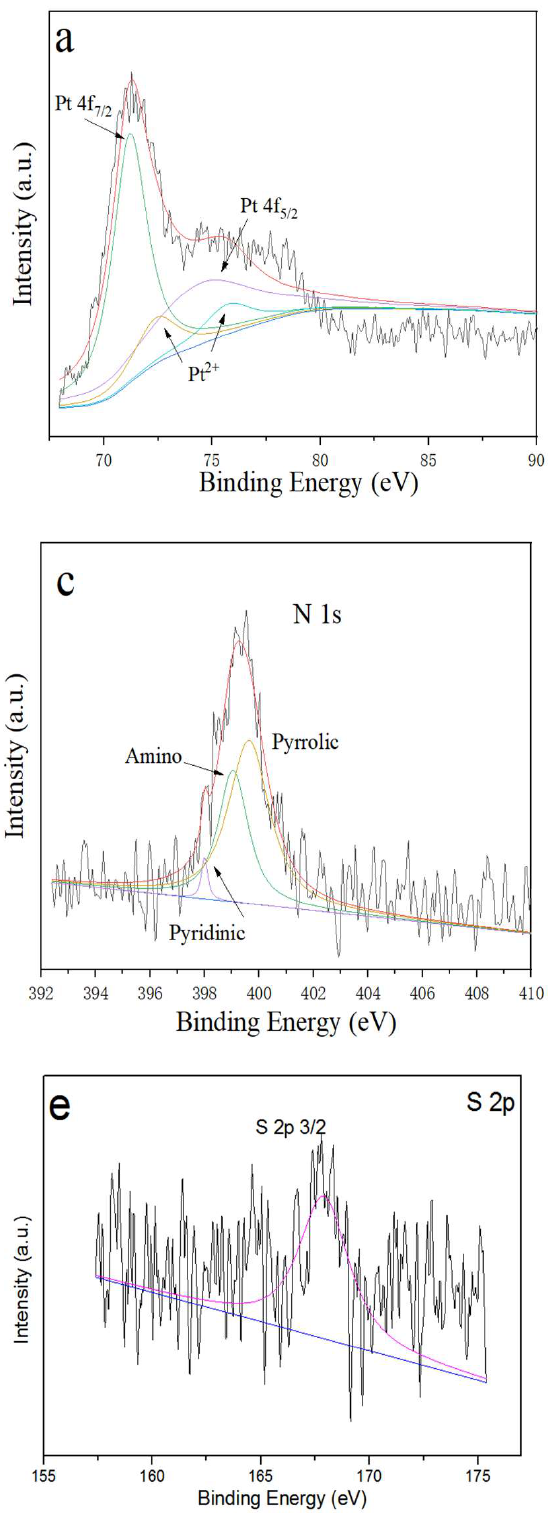
Figure 4. XPS spectra for different elements of PtNi/(N)S-rGo catalyst (a) Pt(b) Ni(c) N(d) C(e)S.